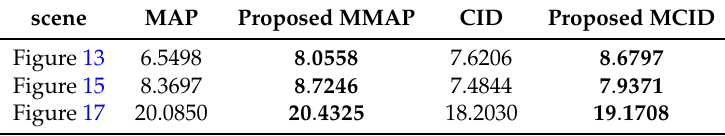
Table 4. The IC of reconstruction results by different methods